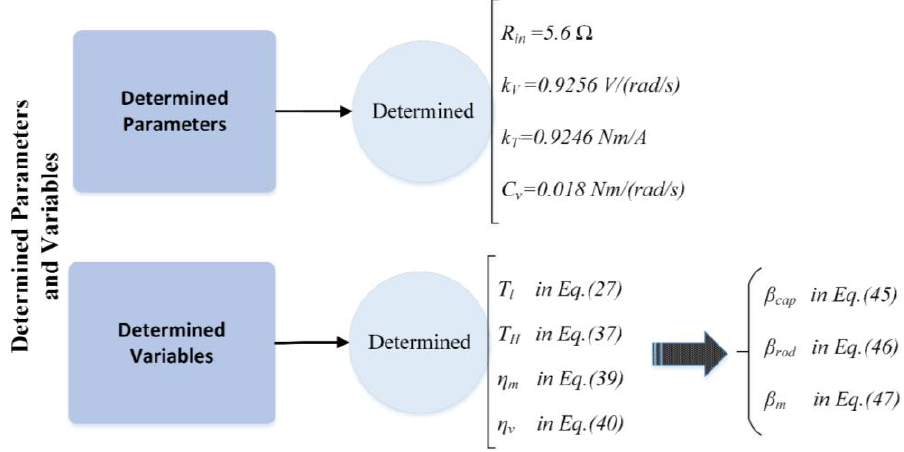
Figure 10. Determined parameters and variables in power regeneration unit and hydraulic system.